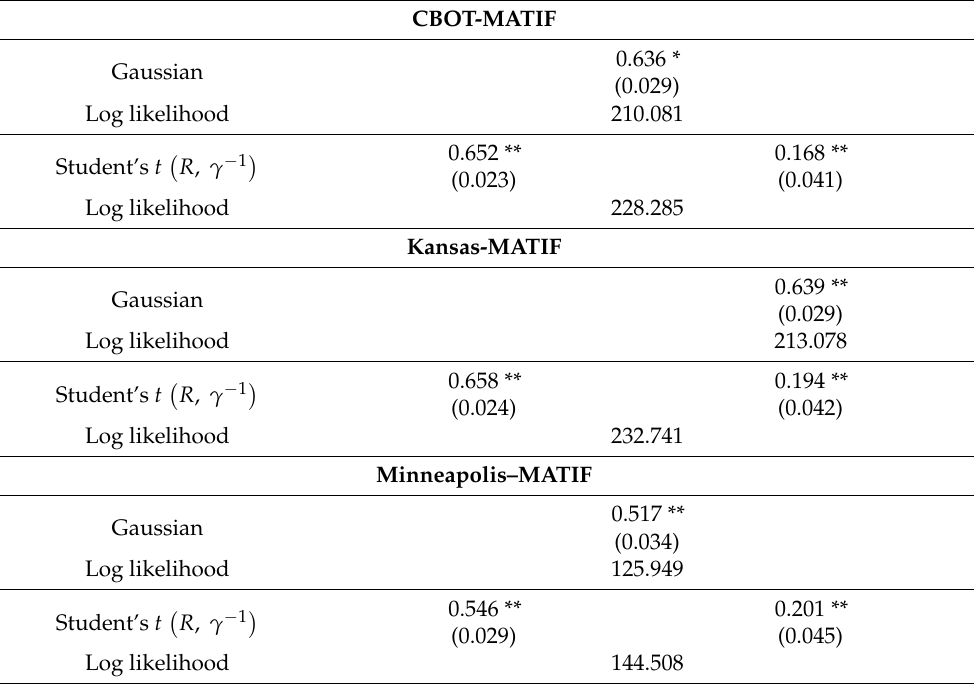
Table 10. Results from static copulas for the second period (2010–2014).